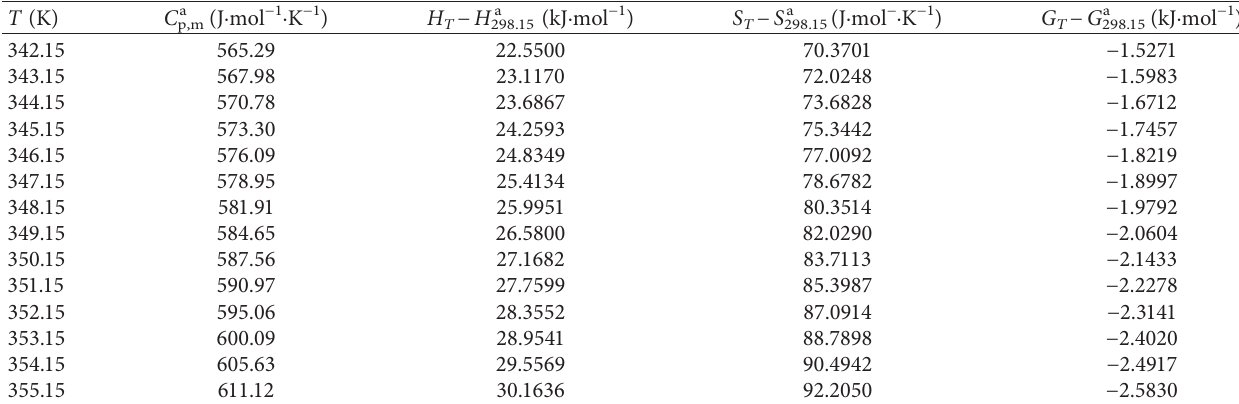
− H − S T 298.15 ), (b) ( S T 298.15 ), and (c) ( G T